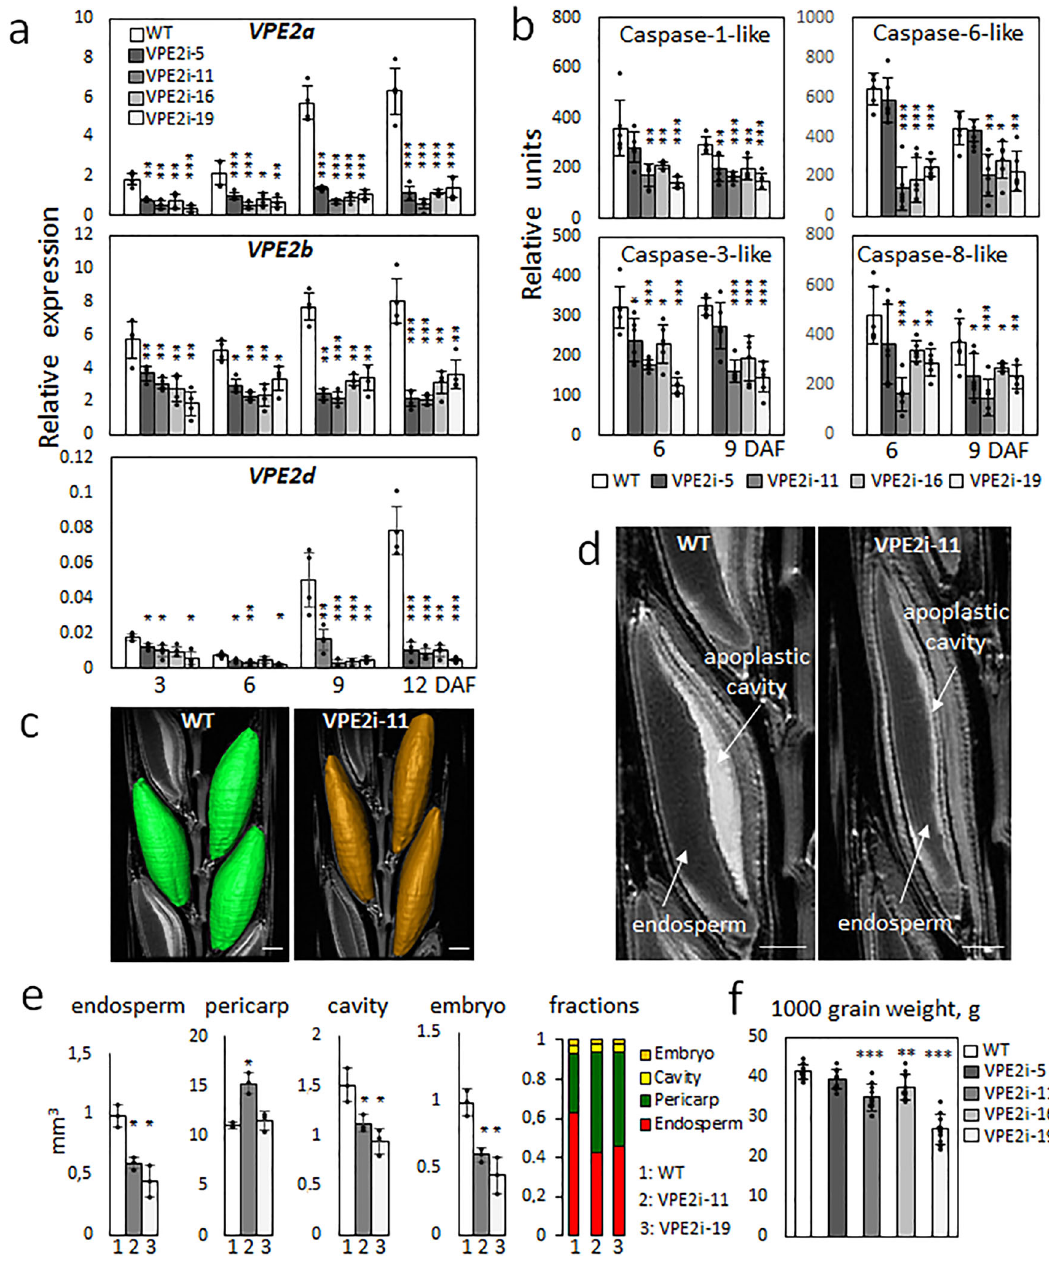
Fig. 3 The phenotypic effect of suppressing VPE2 subfamily. a The abundance of VPE2a , VPE2b, and VPE2d transcripts in the developing grains of WT and RNAi-VPE2 transgenic lines, as measured by qRT-PCR. b Caspase-like activities in the developing grains of WT and transgenic lines. c MRI-derived three- dimensional models of the WT (labeled green) and VPE2i-11 (brown) caryopses (nine DAF). d The inner structure of the developing living caryopses, as acquired by MRI (9 DAF). Three-dimensional visualization of WT, VPE2i-11, and VPE2i-19 grains is shown in Supplementary Movies 1, 2, and 3. e The volume of each of the various components of the caryopsis and their relative contribution to the grain ’ s overall volume. f The weight of 1000 mature grains. Bars = 1mm in c and d . Data given as the mean±SD ( n = 4 in a , = 6 in b , = 3 in e , and = 10 in f ). *, **, ***: means differ at, respectively, P <0.05, <0.01, and <0.001. Abbreviation: DAF days after fl